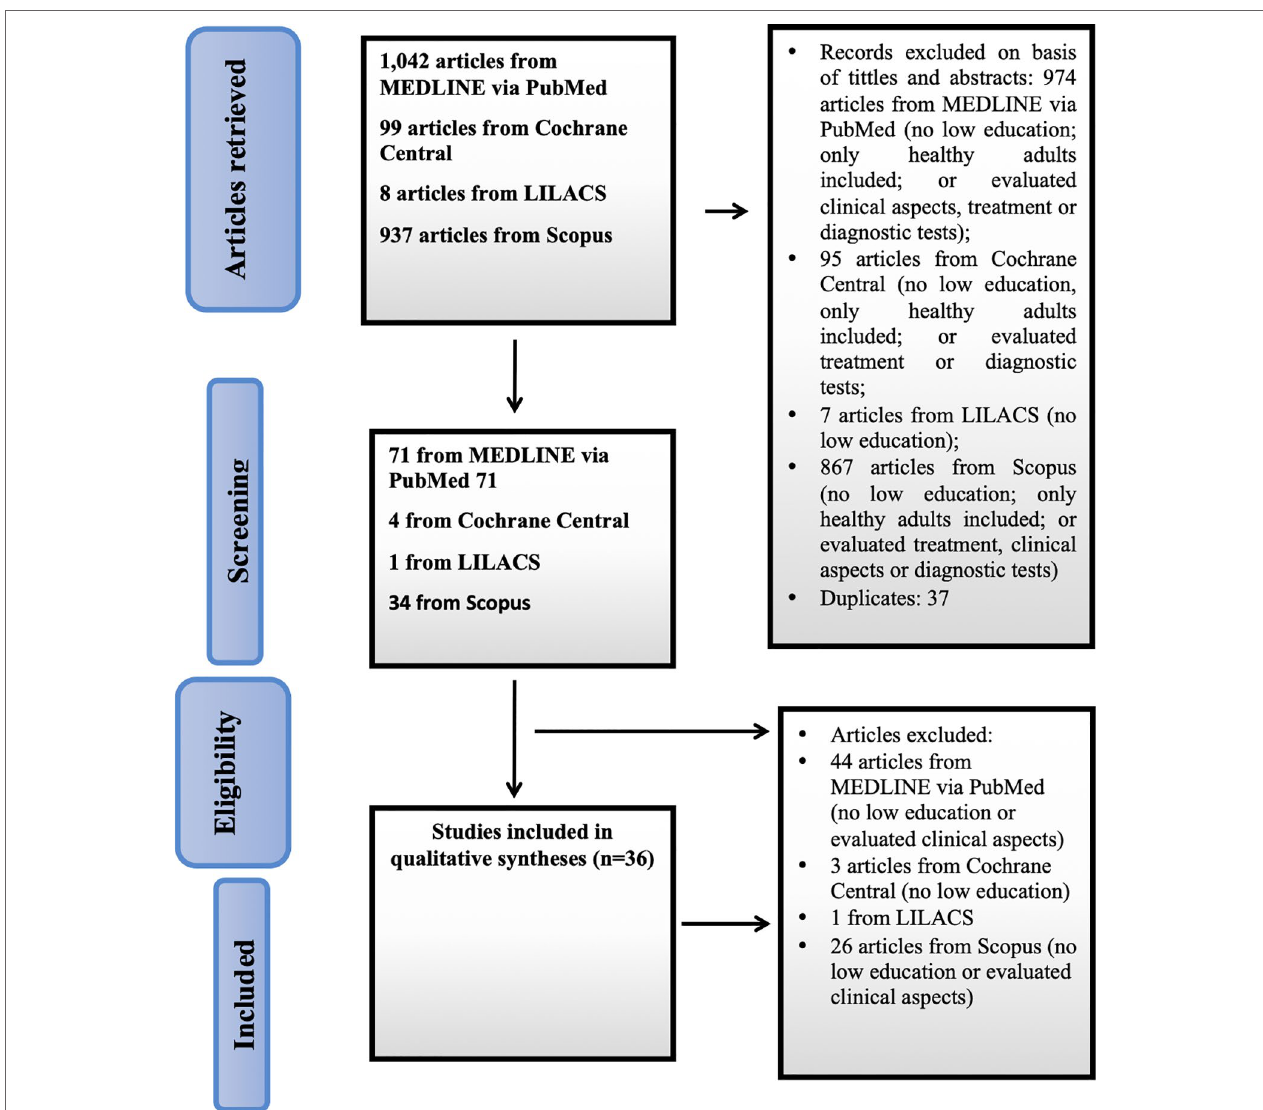
FIGURE 1 | Flowchart of study